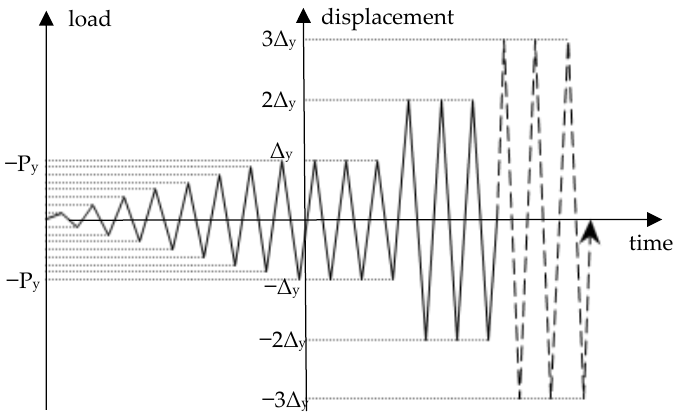
Figure 3. Boundary conditions and vertical loads.